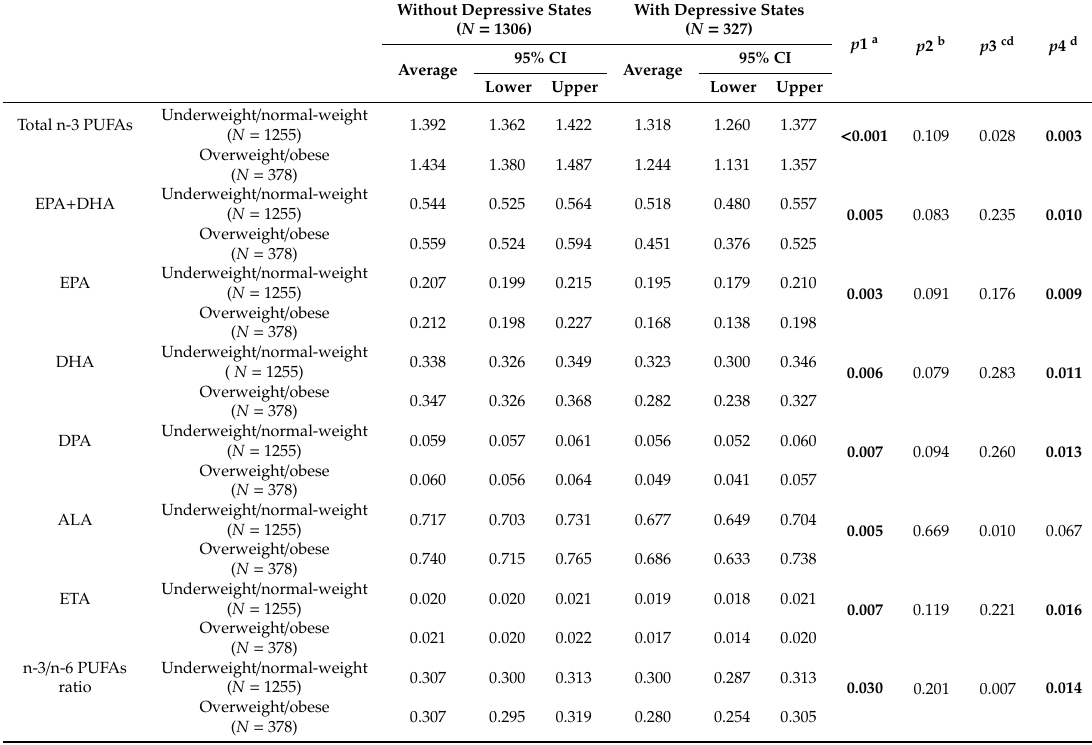
Table 4. Influence of weight status on the association between n-3 PUFAs intake and depressive states (two-way